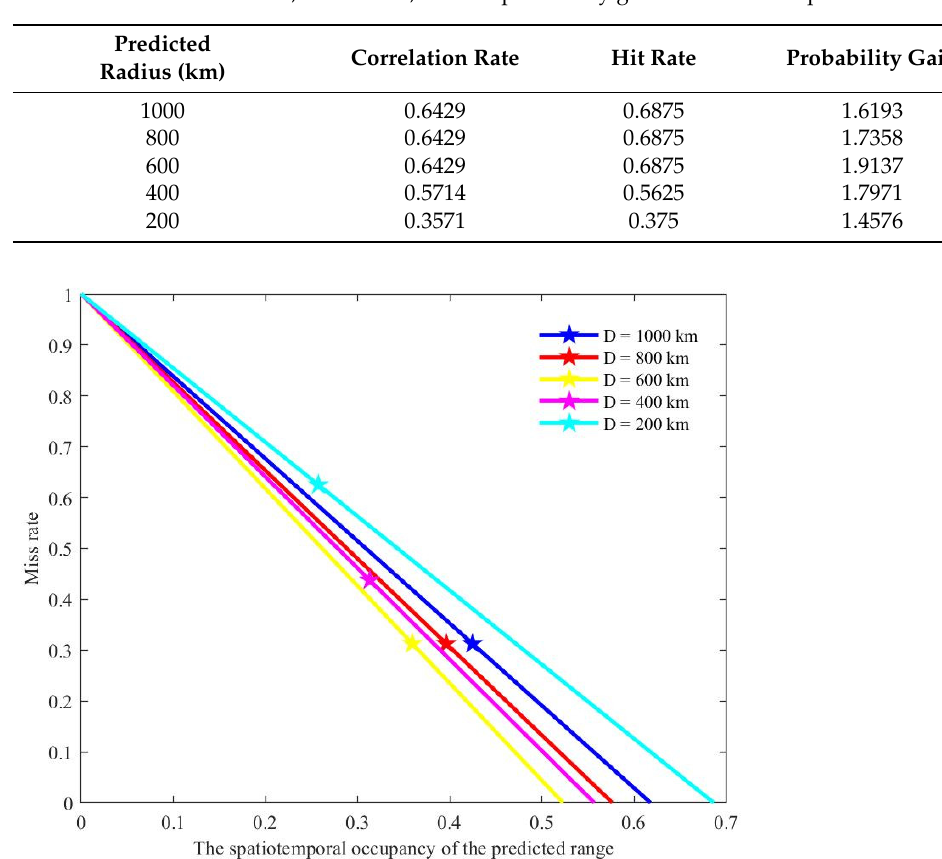
Table 6. The correlation rate, the hit rate, and the probability gain with different parameters.